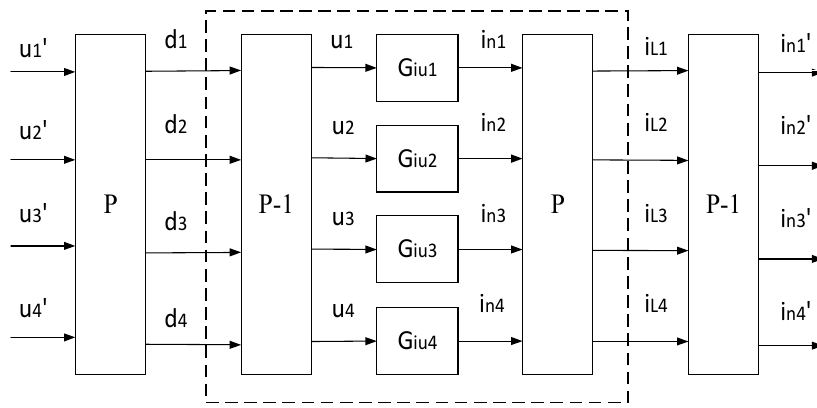
Figure A1. Block diagram of decoupling current loop control.